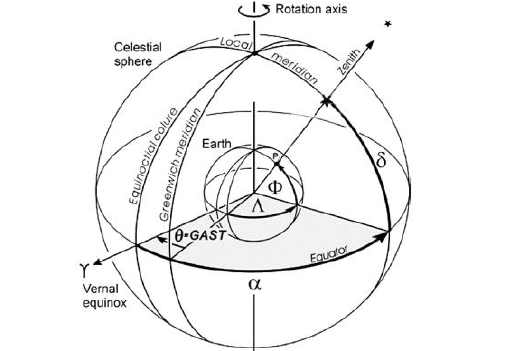
Figure 1. Astronomical coordinate and observation